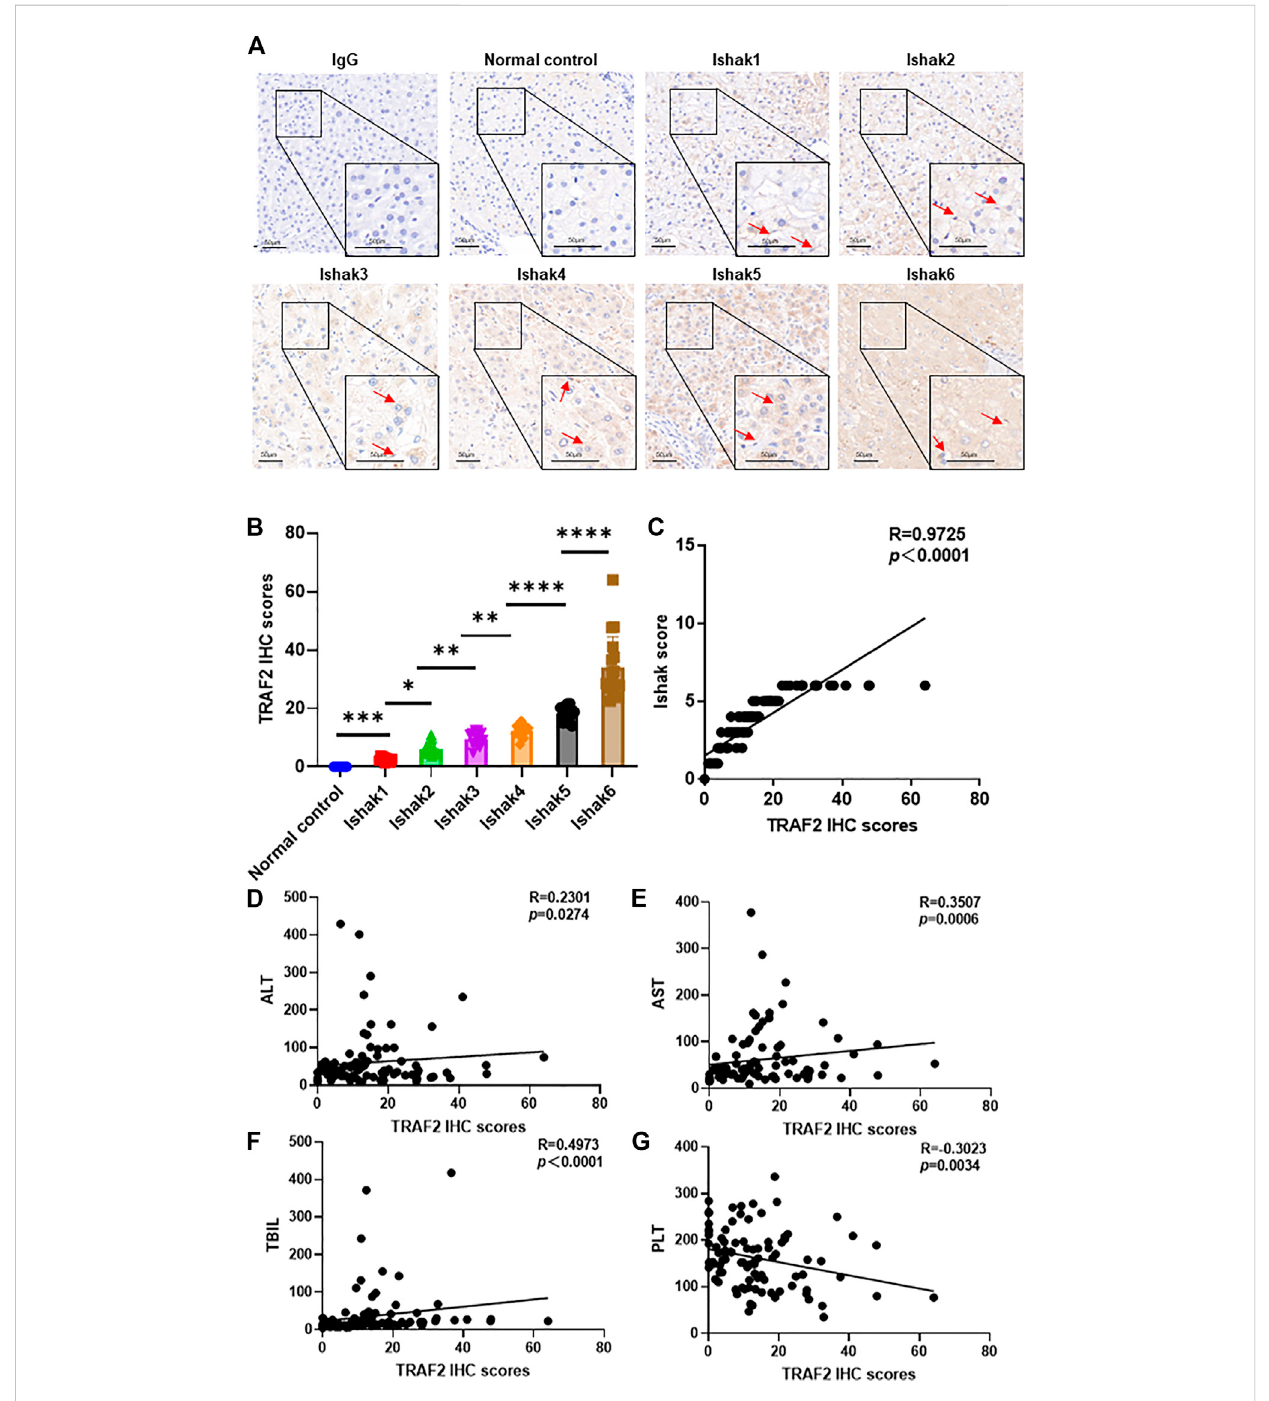
FIGURE 5 Correlation of TRAF2 with HBV-induced liver fi brosis severity. (A) Based on the Ishak score (Ishak1 – Ishak6), immunohistochemistry was used to assess the expression of the TRAF2 protein in hepatic fi brosis caused by HBV. IgG was used as the negative control. Scale bar: 50 µm. (B) TRAF2 expression was analyzed using Image J software. (C) Spearman ’ s correlation analysis of the relationship between TRAF2 expression and the severity of HBV-induced hepatic fi brosis. (D – G) Spearman ’ s correlation study of the relationship between ALT (D) , AST (E) , TBIL (F) , and PLT (G) and TRAF2 expression. Data are expressed as mean ± SEM or median M (P25, P75). Two independent samples t-tests or the Mann-Whitney U rank-sum test are used to evaluate the differences between groups. * p < 0.05; ** p < 0.01; *** p < 0.0001; **** p < 0.00001. TRAF2, TNF receptor-associated factor 2; ALT, alanine aminotransferase; AST, aspartate aminotransferase; TBIL, total bilirubin; PLT,